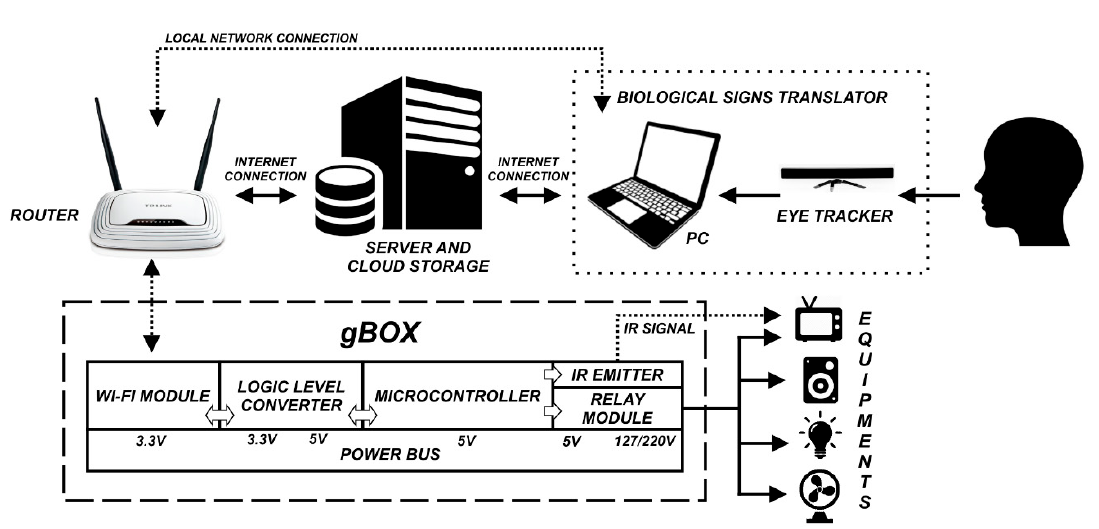
Figure 2. Functional model of the eye/gaze-tracking-based control system.